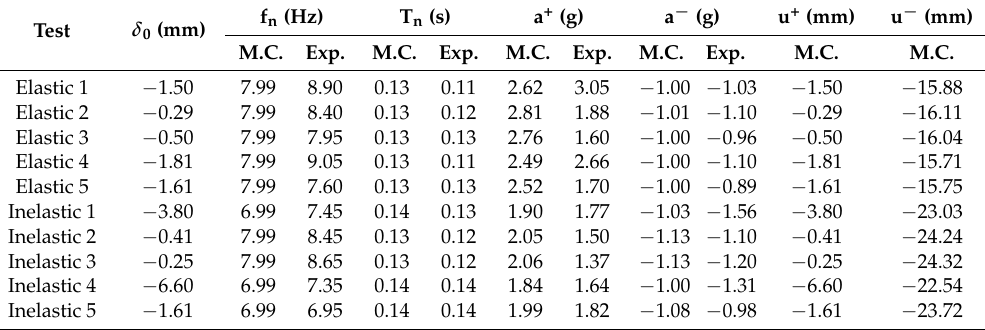
Table 2. Dynamic results of modified catenary experiments. M.C.—modified catenary model;